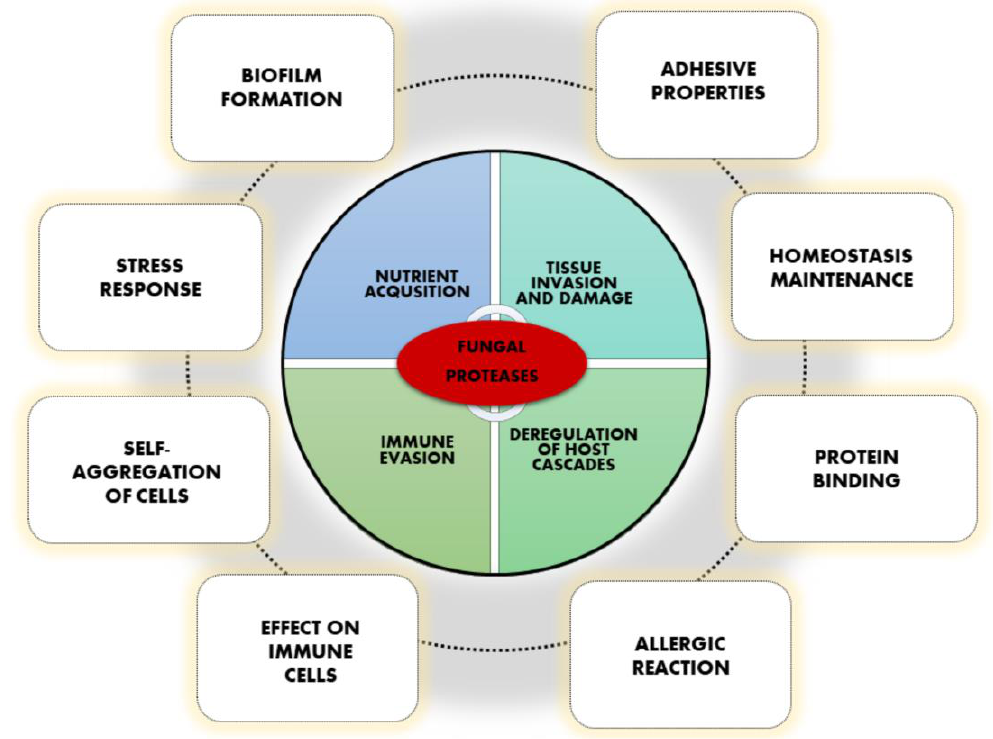
Figure 1. Various functions of fungal proteases important in virulence.